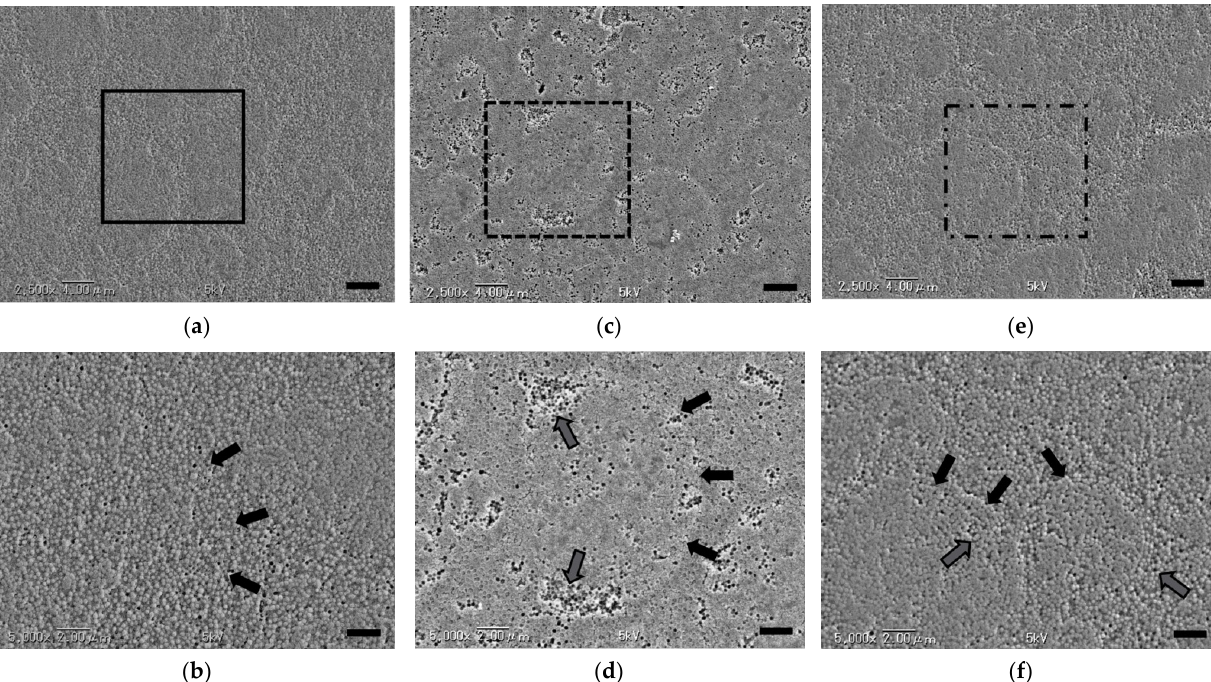
Figure 10. Representative SEM images of the various samples. ( a ) Mirror-polished sample (bar = 4.0 µm). ( b ) Higher magnification image of the square in (a) (bar = 2.0 µm). The black arrows indicate the filler and base resin are tightly bonded. ( c ) Alkaline-degraded sample (bar = 4.0 µm). ( d ) Higher magnification image of the dashed square in (c) (bar = 2.0 µm). The black arrows indicate the boundaries between the spherical organic filler particles and base resin. The gray arrows indicate voids due to dropout of inorganic filler particles. ( e ) Repolished sample (bar = 4.0 µm). ( f ) Higher magnification image of the dot-dashed square in (e) (bar = 2.0 µm). The black arrows indicate the boundaries of the spherical organic filler particles. The gray arrows indicate voids due to dropout of inorganic filler particles.